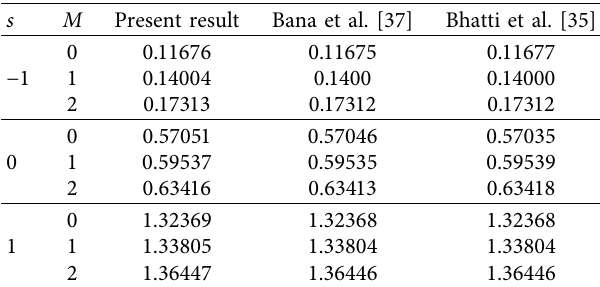
Table 2: Comparison of values of the local Nusselt number (− θ ′ ( 0 )) obtained by the present method and other numerical methods in the existing literature for different s and M values whenPr � 1 , β � Ω � λ �